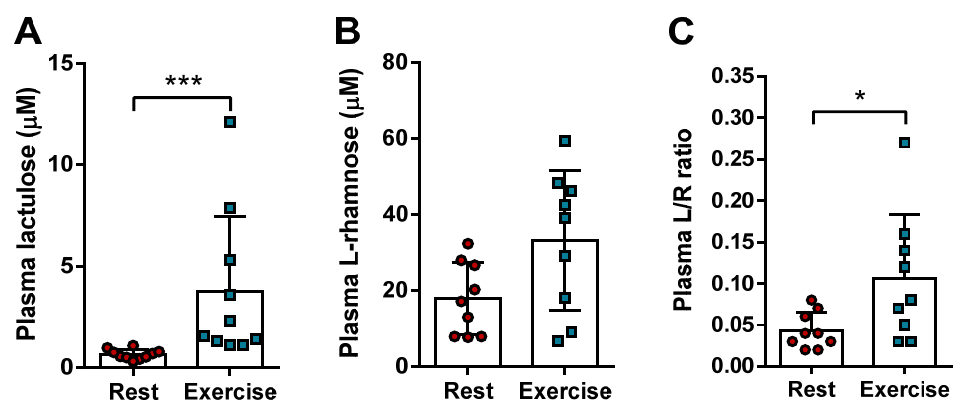
Figure 3. Lactulose and L ‐ rhamnose sugar test for the analysis of intestinal permeability during rest or exercise. Plasma levels of lactulose ( A ) and L ‐ rhamnose ( B ) (Mean ± SD) were measured after intake of the dual sugar solution followed by rest (red circle) or exercise (blue square). From these, the Lactulose ‐ over ‐ L ‐ rhamnose (L/R) ratio was calculated ( C ). * represents a p ‐ value < 0.05; *** represents a p ‐ value < 0.001.